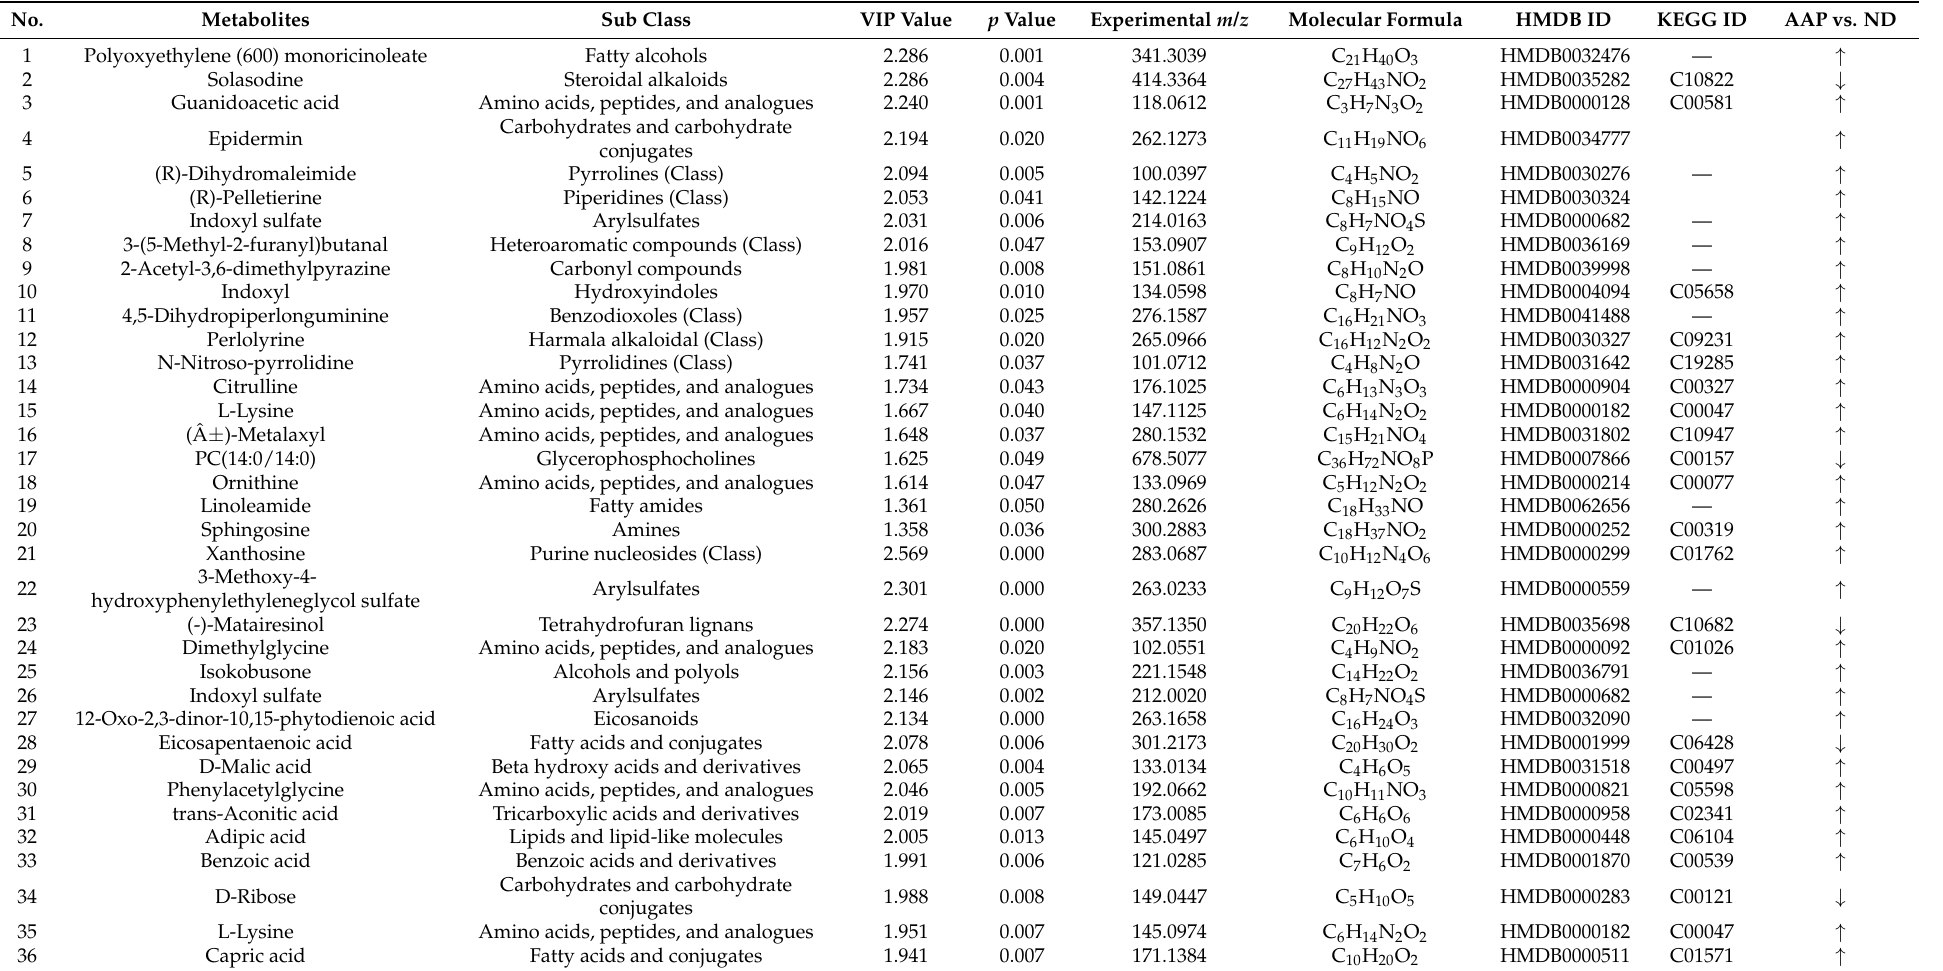
Table 1. Identification of mice serum metabolites after administering Auricularia auricula